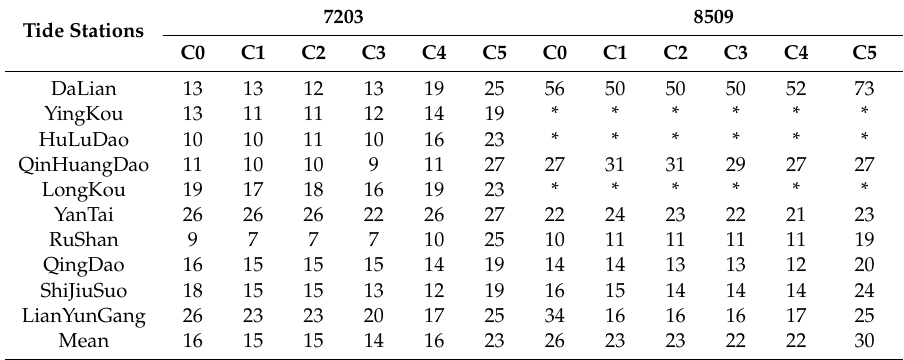
Table 3. Mean square errors between simulation and observation of storm surge levels at tide stations during Typhoons 7203 and 8509 (unit: